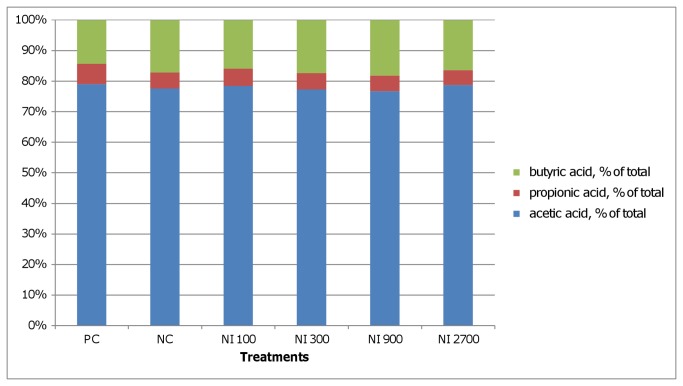
SCFA profiles in caeca digesta.PC - positive control (salinomycin, 60 mg/kg); NC- negative control (any additives); NI100 - 100 IU nisin/g (3.2 ml/kg); NI300 - 300 IU nisin/g (9.7 ml/kg); NI900 - 900 IU nisin/g (20.1 ml/kg); NI2700 - 2700 IU nisin/g (87.2 ml/kg); Different letters indicate significant differences between treatments (P≤ 0.05).